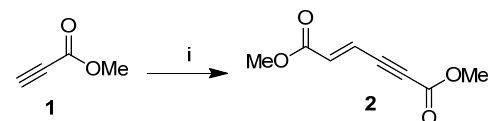
Scheme 1. Preparation of propiolate dimer 2